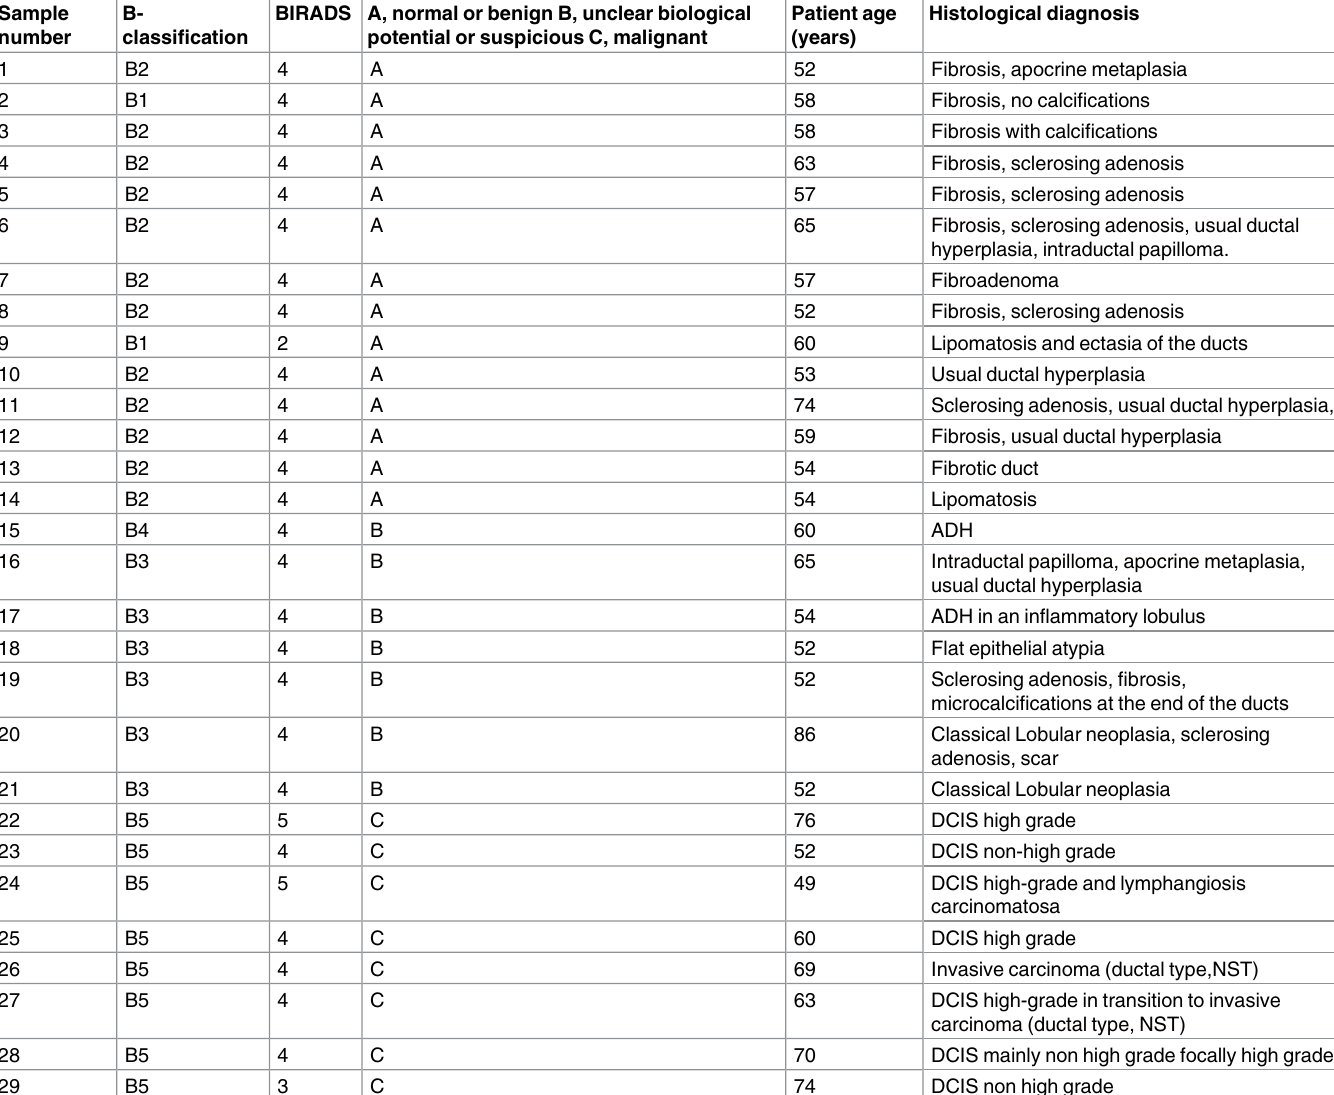
Table 1. Patient age and overview of the histologic (B-classification) and radiologic (BIRADS) evaluation. Sample B- number